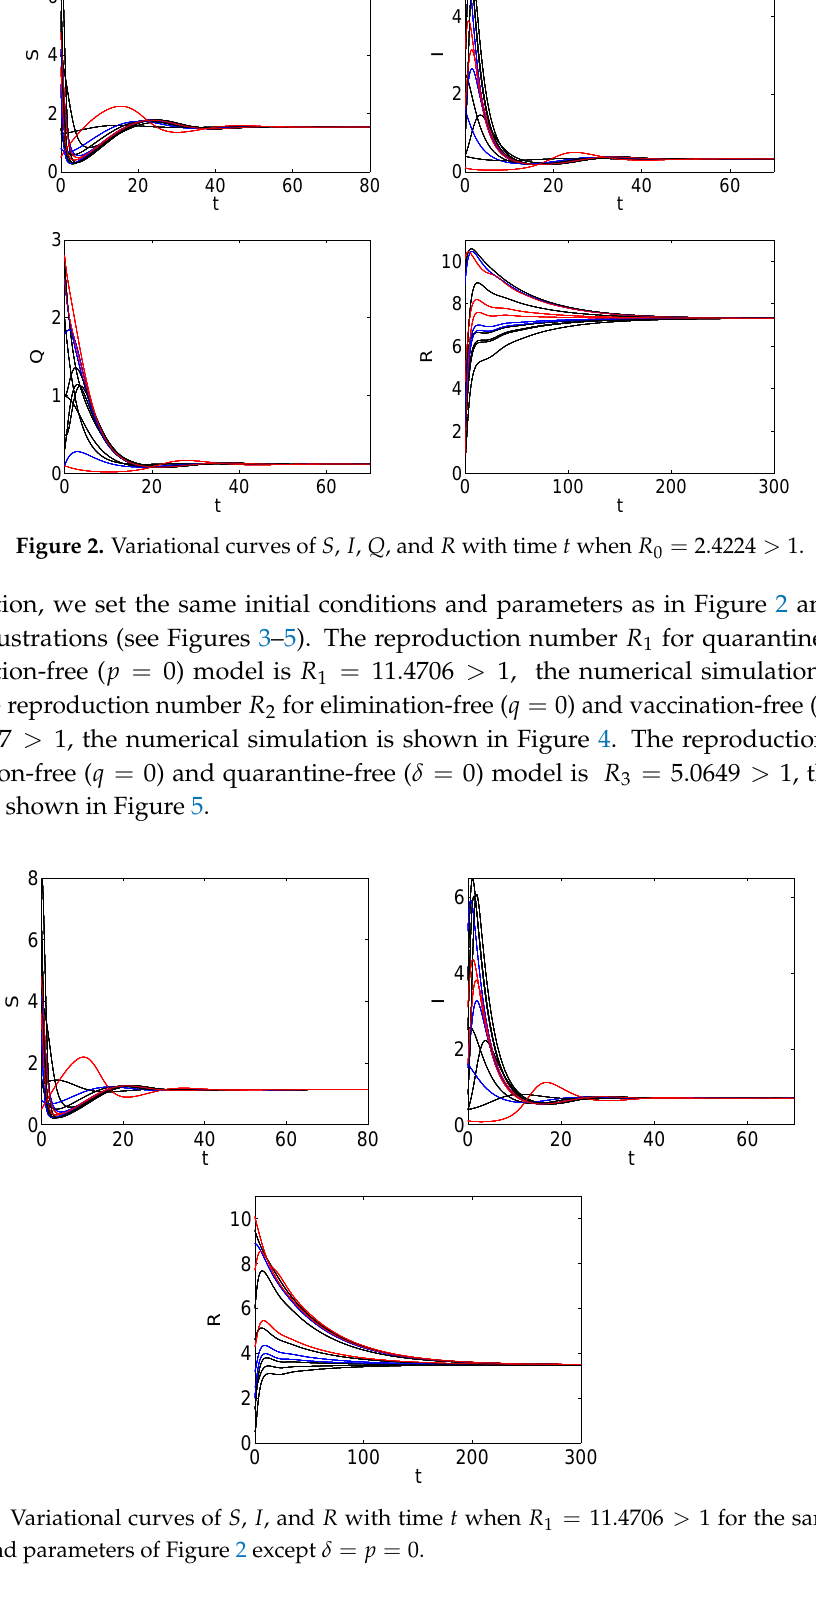
Figure 3. Variational curves of S , I , and R with time t when R 1 = 11.4706 > 1 for the same initial values and parameters of Figure 2 except δ = p =